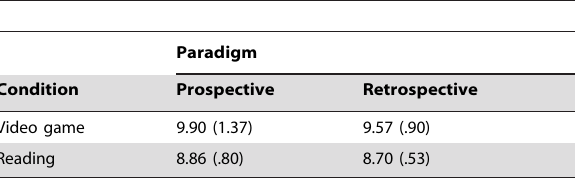
Table 2. Mean age (standard deviation) of participants in each